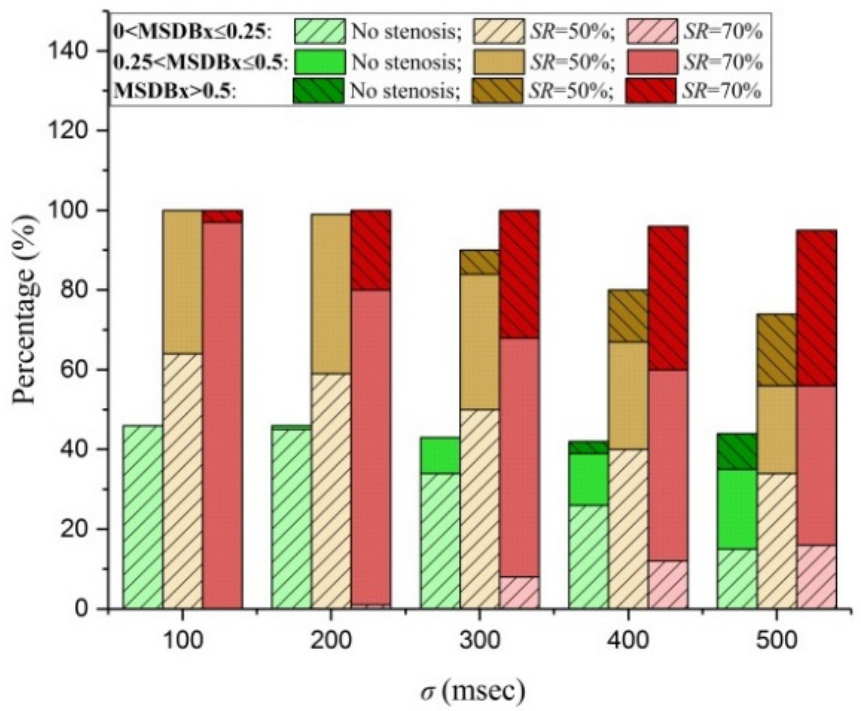
Figure 8. Proportions of cardiac cycles with mild myocardial ischemia (0 < MSDBx ≤ 0.25), moderate myocardial ischemia (0.25 < MSDBx ≤ 0.5) and severe myocardial ischemia (MSDBx > 0.5) within 100 consecutive cardiac cycles with various severities of R-R interval irregularity. The coronary artery is set to be normal (no stenosis), or have a moderate ( SR = 50%) or severe ( SR = 70%) stenosis.